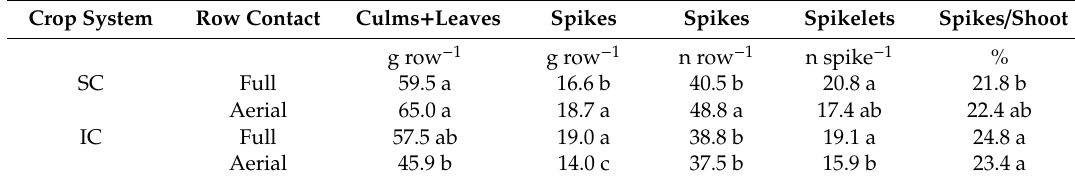
Table 5. Biomass of shoot plant parts, and spike yield components in triticale, as a ff ected by the Crop System × Row contact interaction. SC, sole crop; IC, intercrop. For each parameter, values followed by the same letter within a column are not significantly di ff erent at P < 0.05, Tukey’s test.